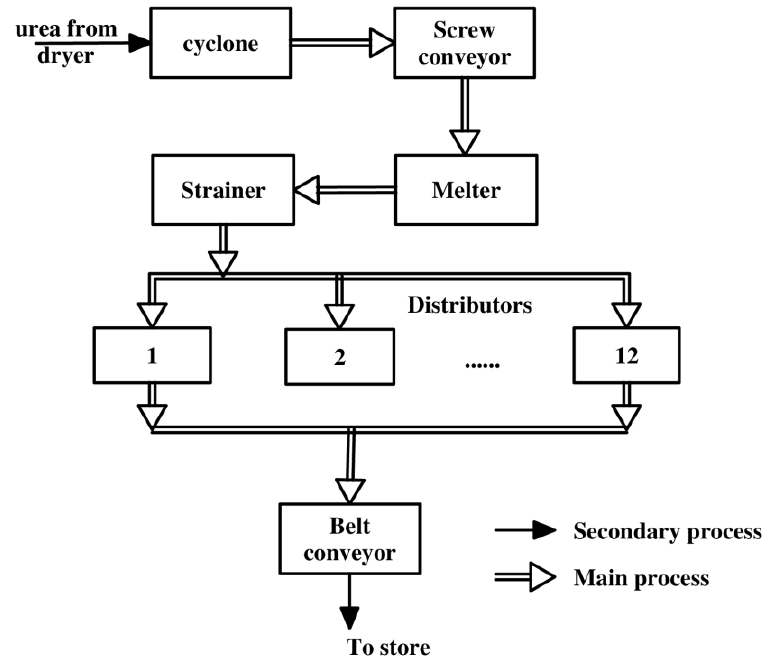
Figure 1. Systematic diagram of prilling and carbon recovery